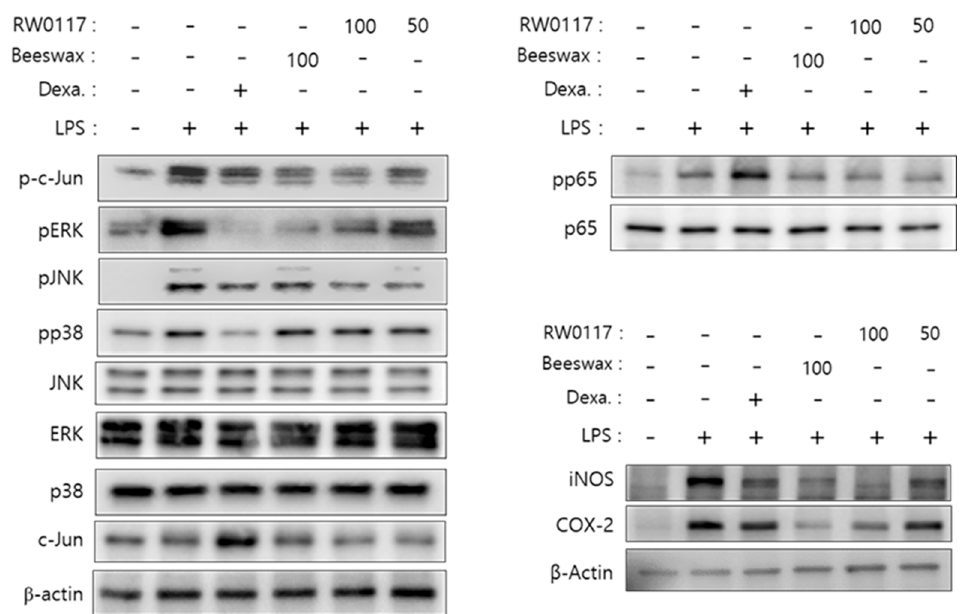
Figure 5. Effect of RW0117 on the phosphorylation of several signaling proteins in LPS-stimulated RAW264.7 cells; ( − ): DMSO (0.05 %)-treated group, Beeswax: beeswax alcohol-treated group,